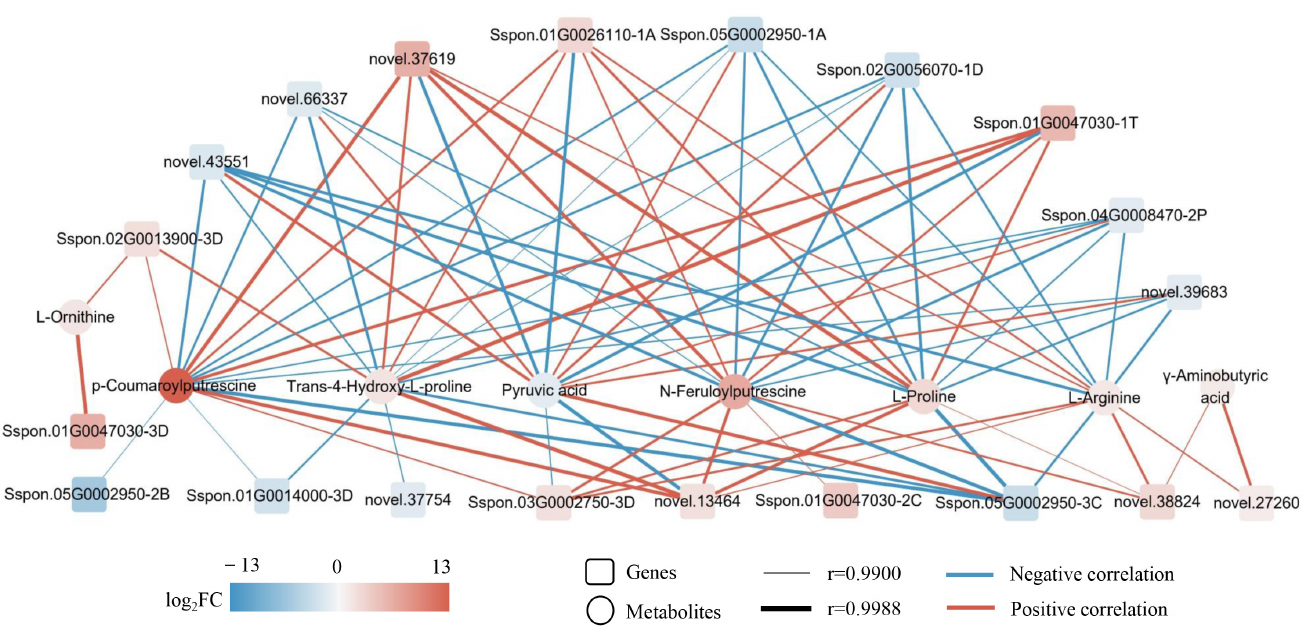
Figure 11. Correlation network graph of DEGs and SRMs in the arginine and proline metabolism pathway for comparison of the CG and DS groups. The genes and metabolites color-coded according to fold-change between the CG and DS groups. |log 2 FC| denotes |log 2 Fold Change|.